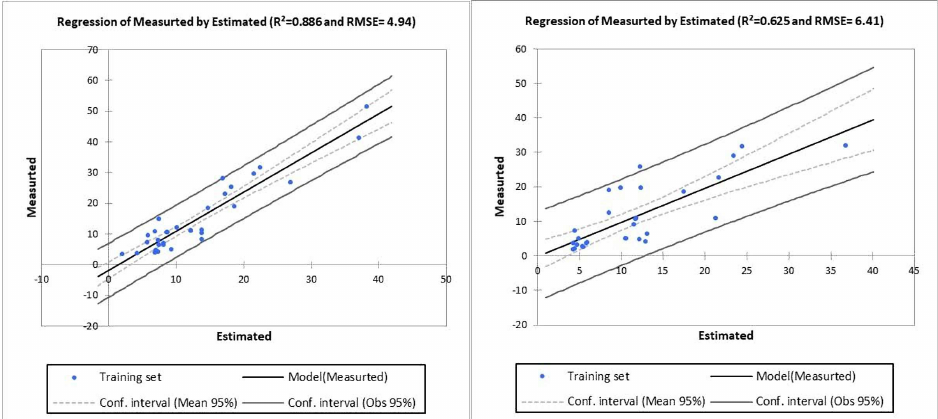
Figure 6. Scatterplot of estimated versus measured SMC (m3/m3) values evaluated on test samples. ( left ) pixel-based approach; ( right ) object-based